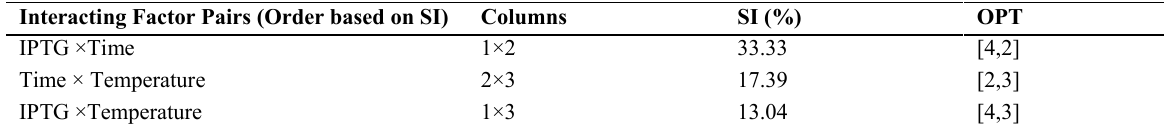
Table 3. Quantlitek-4 analysis.